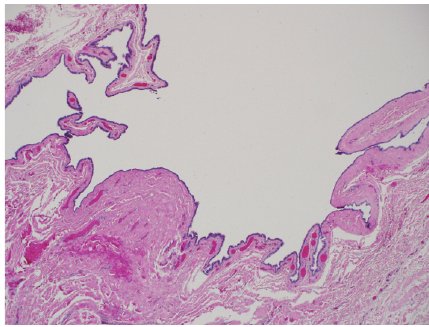
Figure 1: Low power photomicrograph showing a cystic mass with infoldings and excrescences of its wall at the inner aspect. The cyst lining is easily appreciated. H&E. Magnification, 40x.